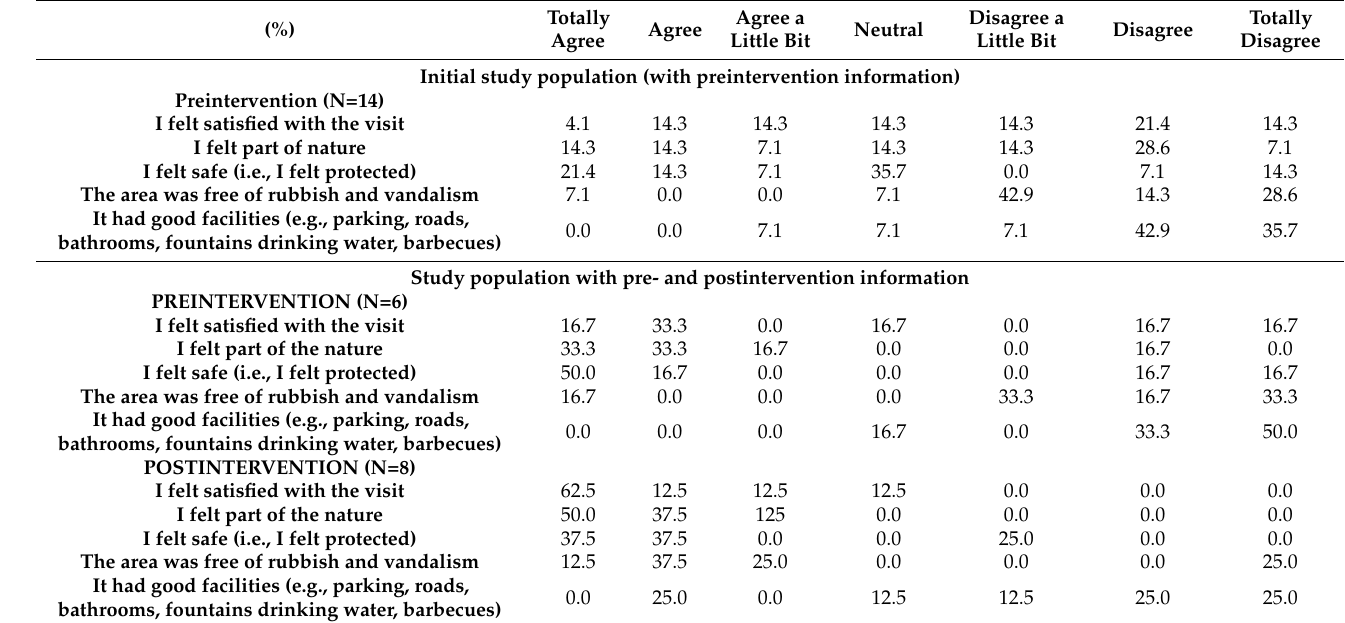
Table 2. How survey respondents felt about their visits to the Can Moritz spring (it only includes respondents who reported visiting the spring in the last four